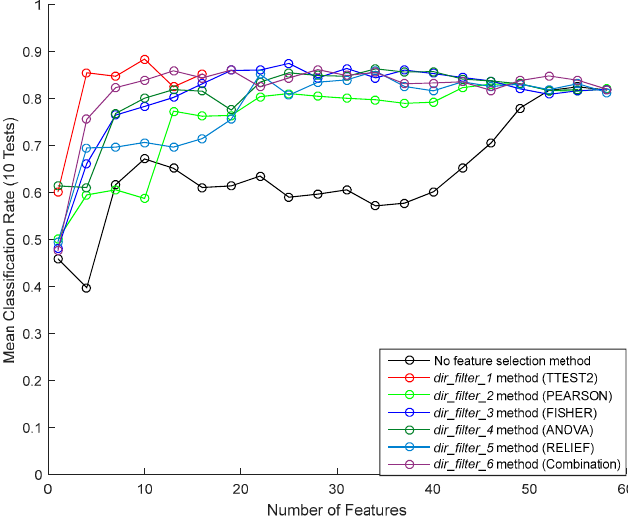
Figure 17. Averages of the recognition rates obtained by the filter selection method.